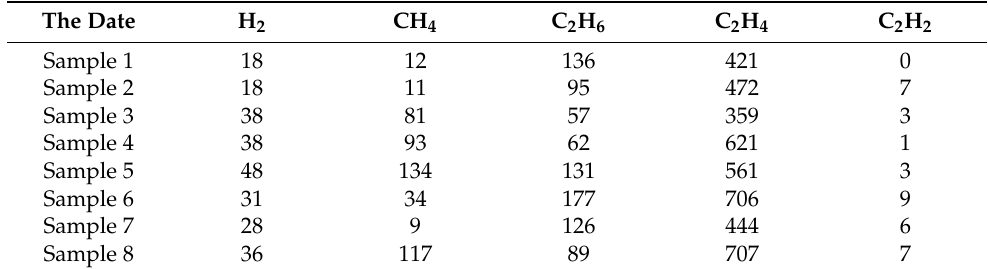
Table 7. DGA history of the case